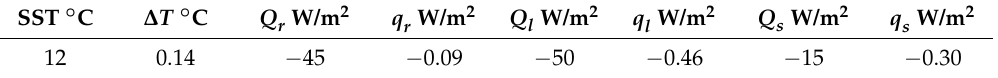
Table 2. Expression of the mean heat fluxes resulting from the SST anomaly ∆ T at high latitudes of the gyres. Q r is the outgoing radiation flux, Q l the latent heat flux, Q s the sensible heat flux, from “European Reanalysis ERA40” [21]. The differential fluxes q r , q l and q s are induced by the SST anomaly. The sensitive heat flux is approximate (Appendix A: The differential fluxes deduced from the SST anomaly). The SST and the ∆ T are indicative since they are intended for the comparative